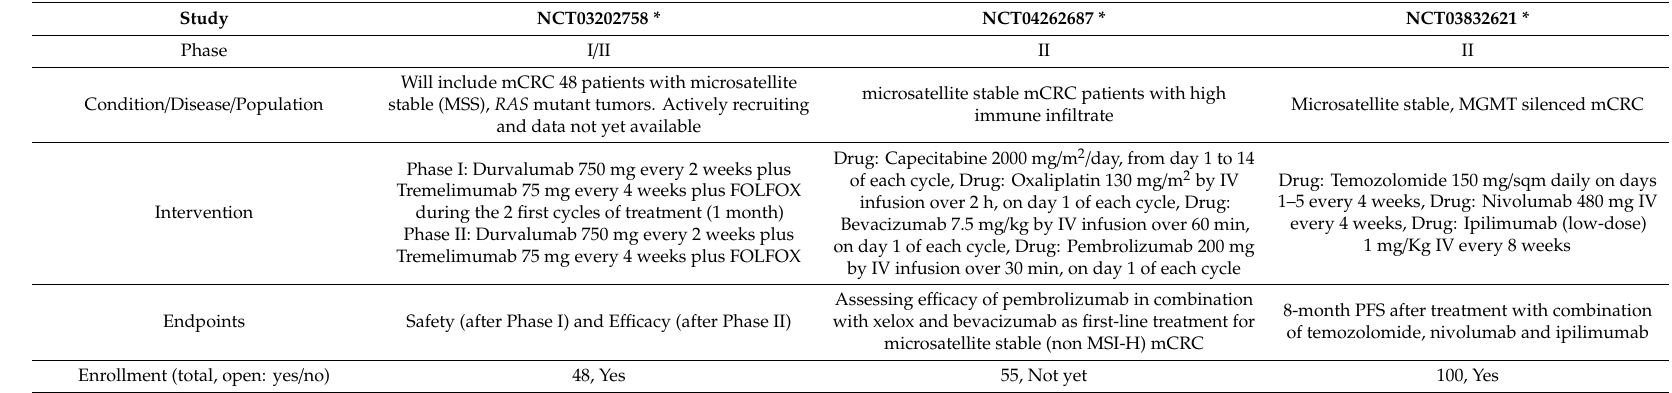
Table 3. Ongoing trials involving checkpoint inhibitors in mCRC